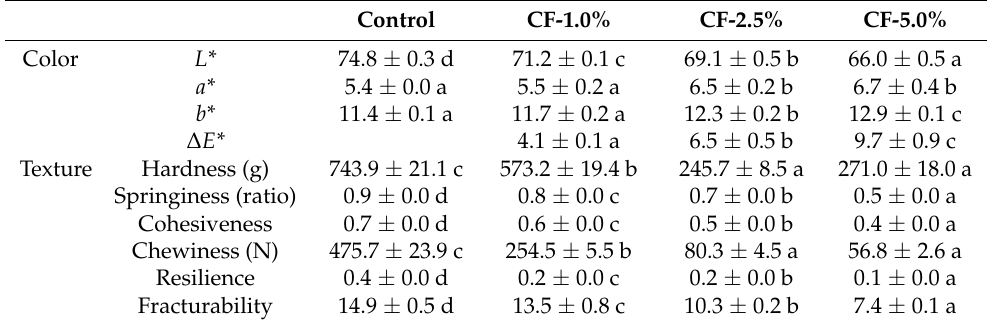
Table 3. Color and texture of cooked sausages formulated with lean pork, pork fat, and cricket